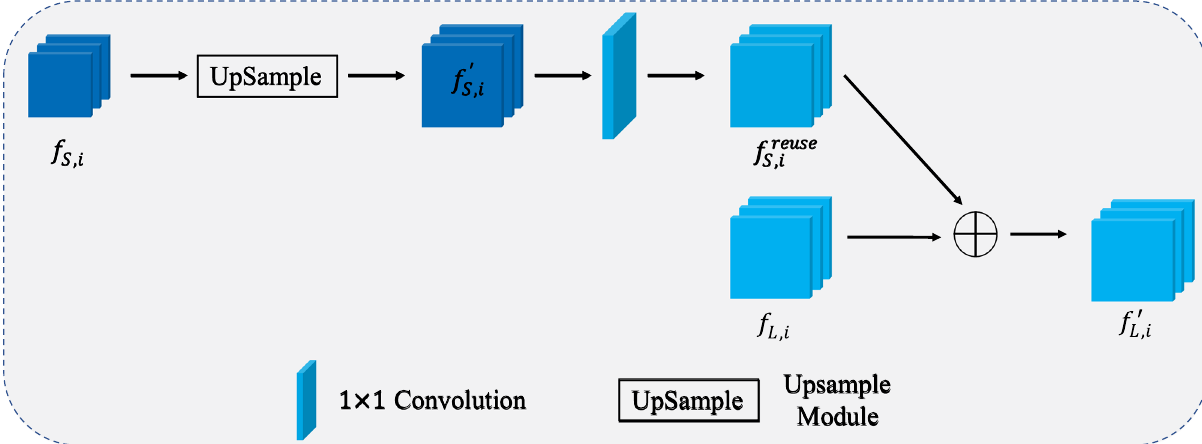
Figure 2. The overall pipeline of the proposed Feature Reuse